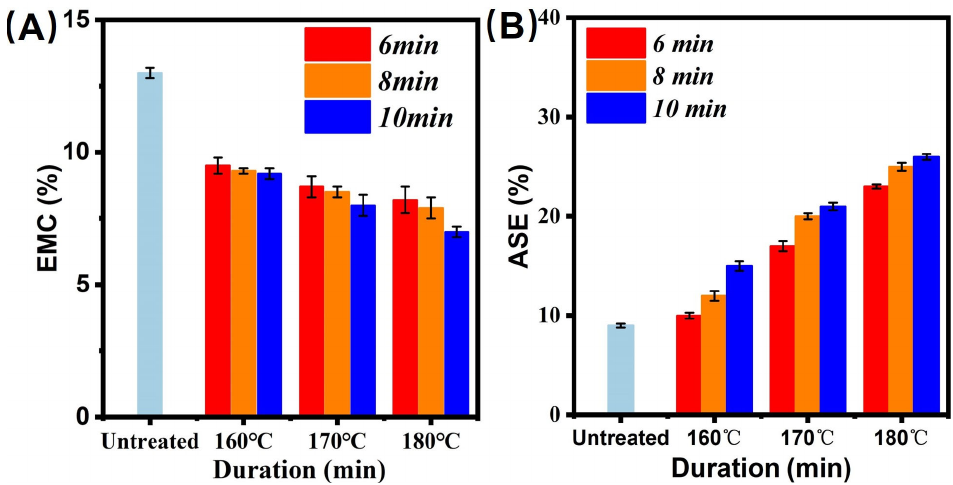
Figure 5. Physical property characterization. ( A ) EMC; ( B ) ASE. Figure 6. Micro ‐ mechanical property characterization. ( A ) modulus of elasticity; ( B ) hardness.